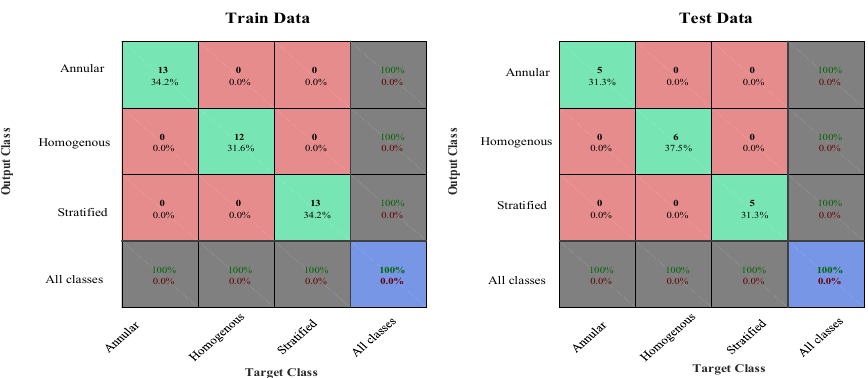
Figure 11. The performance of implemented ANN for regime classification (training and testing data samples).